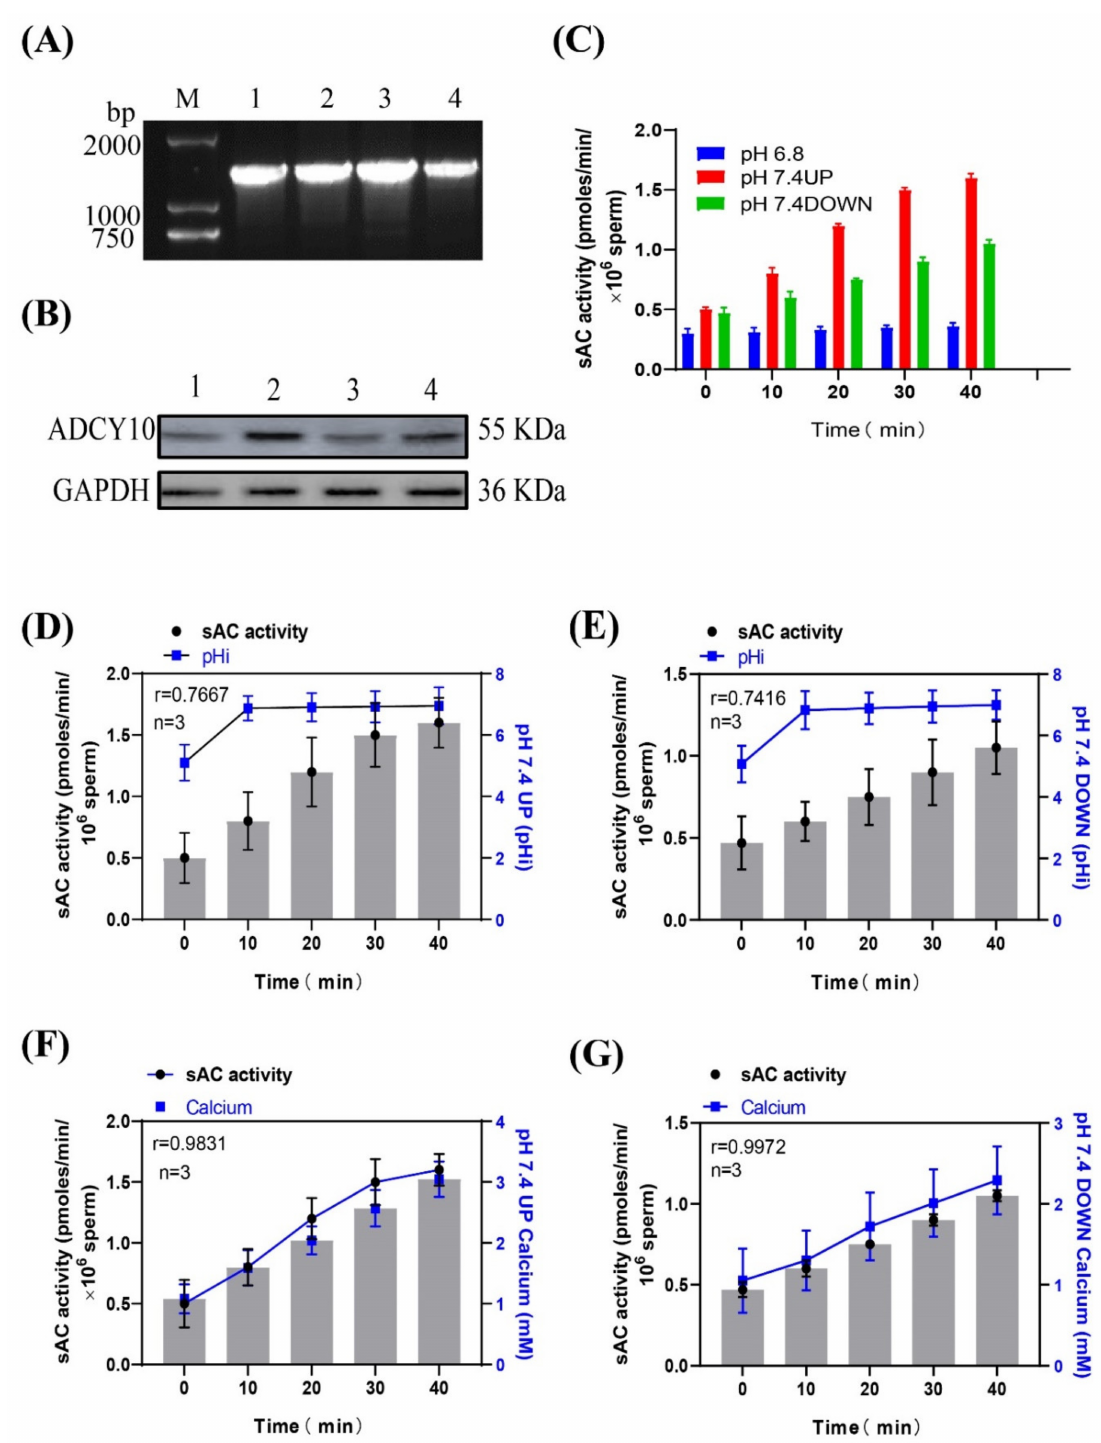
Figure 4. ( A ) Gel electrophoresis of the PCR amplification product of the sAC gene in dairy goat sperm. ( B ) Western blot of sAC from dairy goat sperm. ( C ) Changes in sAC protein activity when sperm were incubated in pH 7.4 dilution. ( D , E ) Relationship between sAC protein activity and pHi during sperm incubation. ( F , G ) Relationship between sAC protein activity and [Ca 2+ ]i concentration during sperm